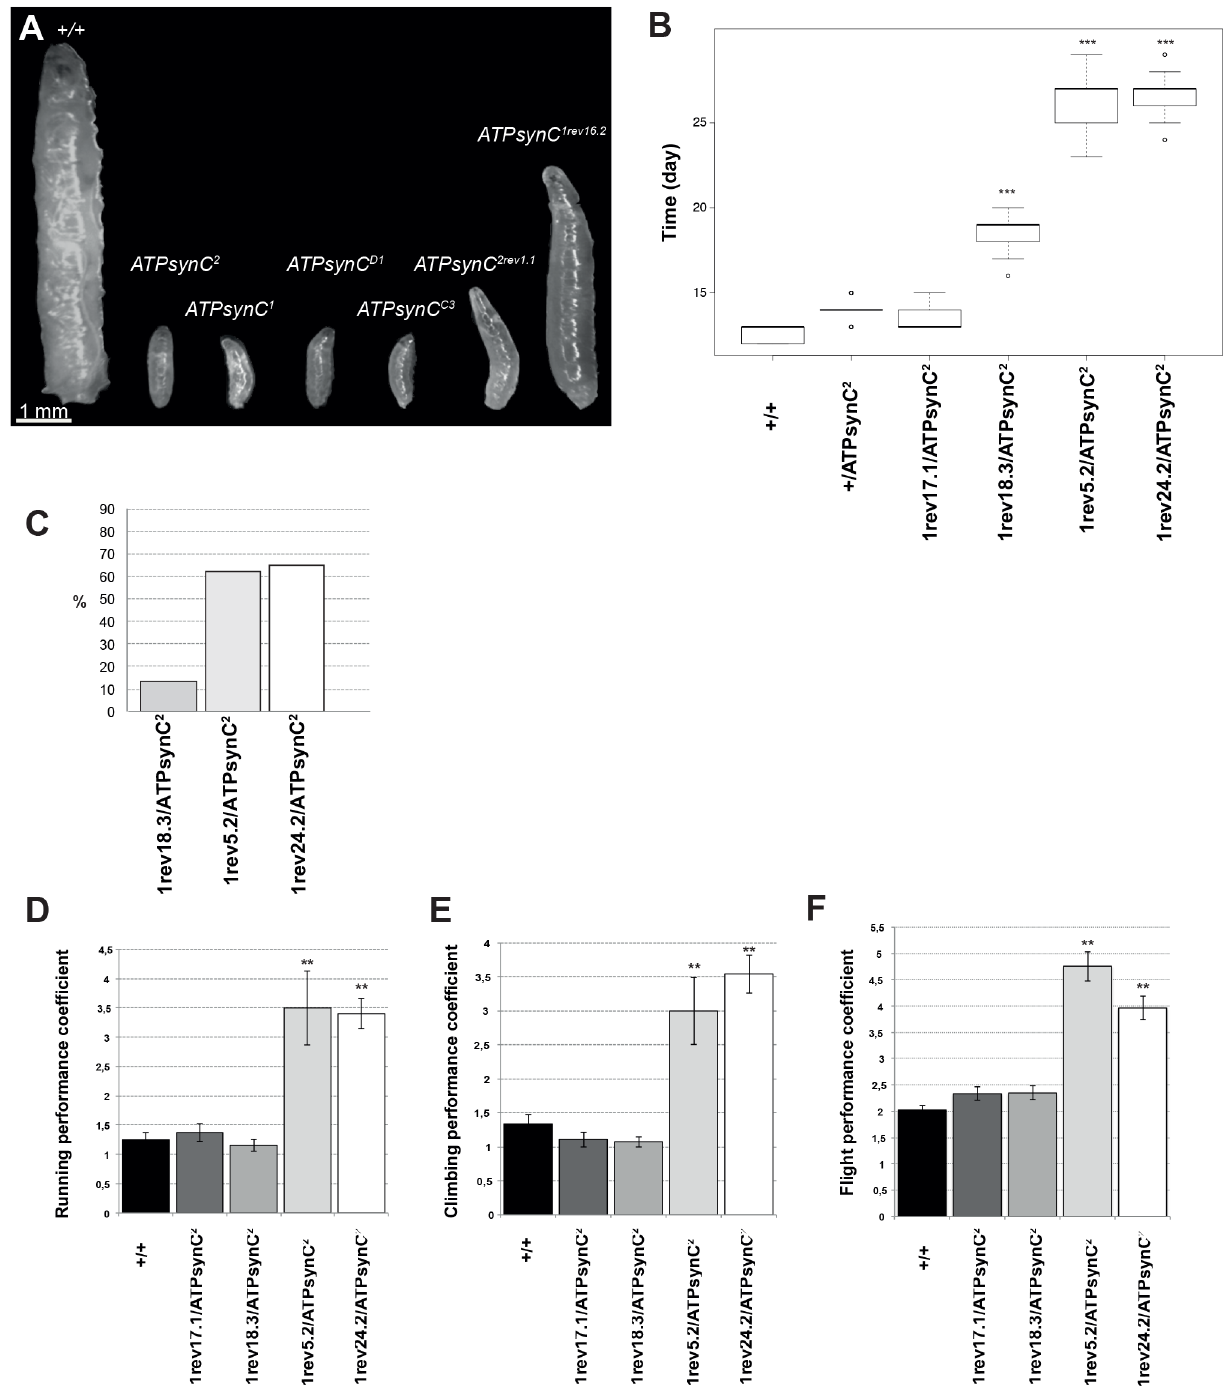
Fig 3. Phenotypic characterization of ATPsynC mutant alleles. (A) Maximal larval development of lethal mutations of ATPsynC . (B) Generation time (from egg to adult) of representative revertant alleles produced by excision of the P-element insertion in ATPsynC 2 . (C) Percentages of early adult lethality of individuals trans-heterozygotes for the ATPsynC pleiotropic mutations characterized in this work. (D-F) Running, climbing and flying performances of representative revertant alleles produced by excision of the P-element insertion in ATPsynC 2 . Higher performance coefficients indicate worse locomotor skills (see Materials and methods section). Statistical significance codes (comparison to wild-type): (cid:3)(cid:3) P < 0.01. +/+ = Oregon-R flies.